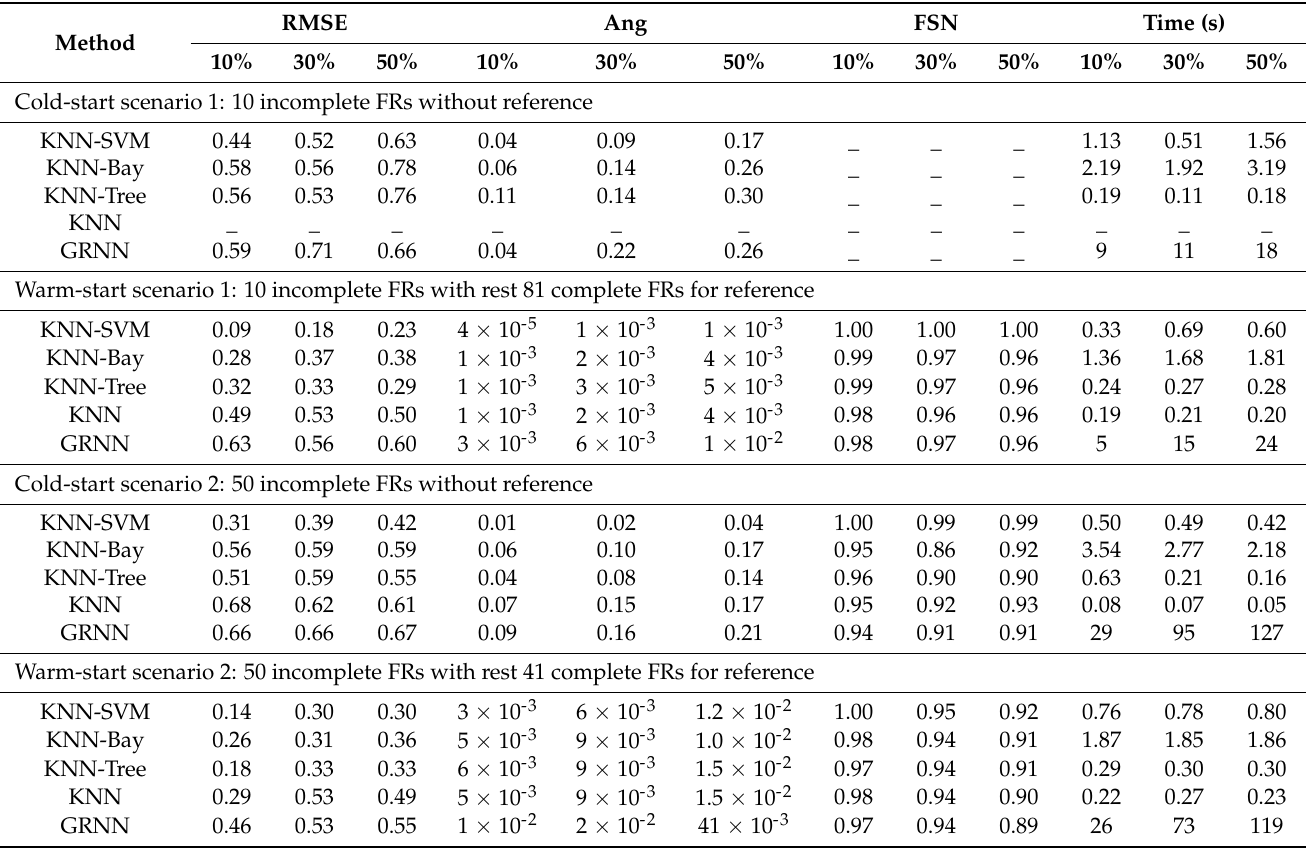
Table 3. Performance of different methods in cold- and warm-start